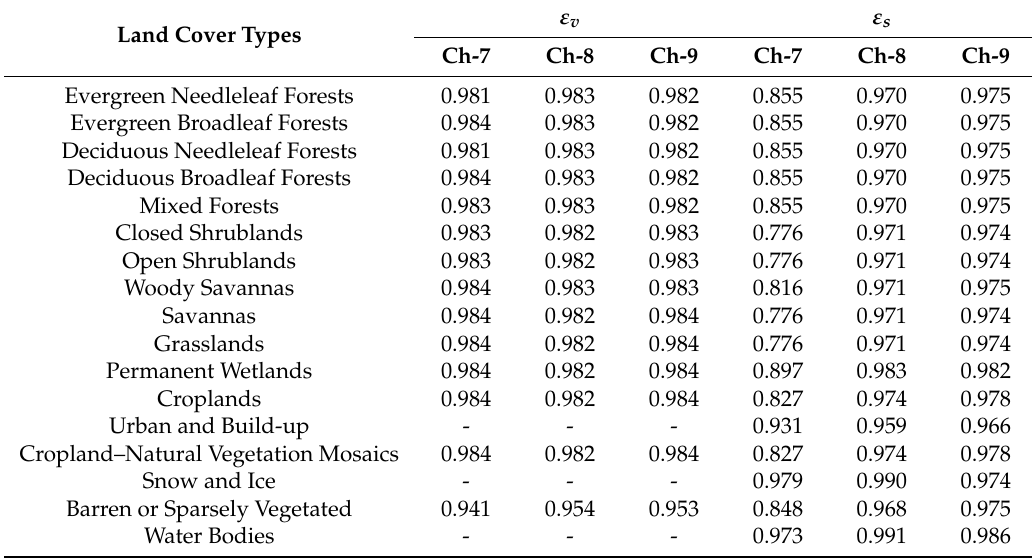
Table 3. Component emissivities of different land cover types in the MIR and TIR